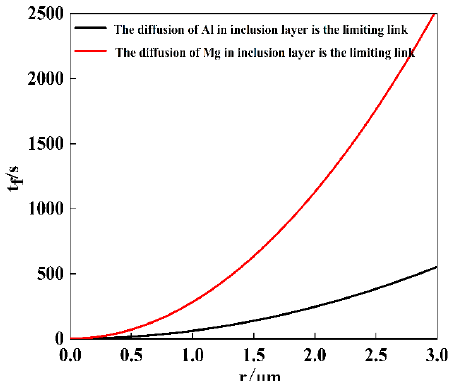
Figure 8. Diffusion of Mg and Al in magnesium aluminate layer is the limiting link of modification process.